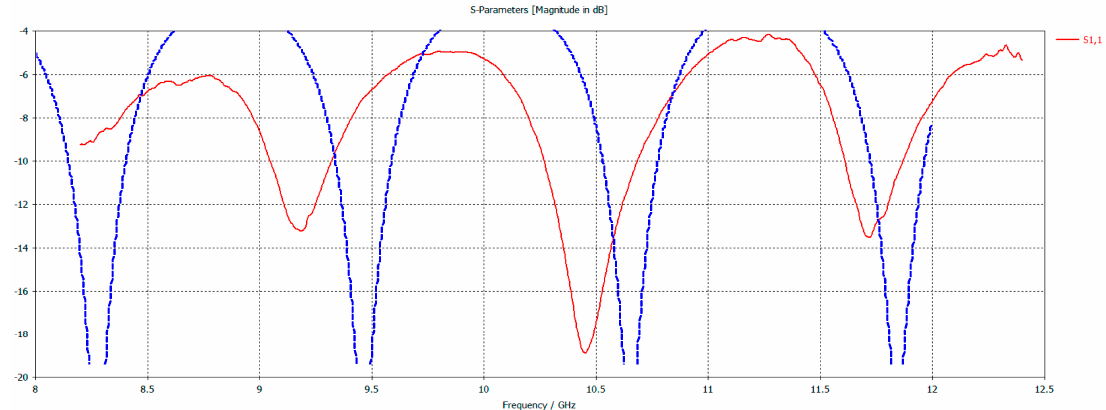
Figure 4. Reflection Coefficient in dB versus frequency by 3D (red continuous line) and plane wave (blue dashed line) simulation results without the glass (mosaic) layer.